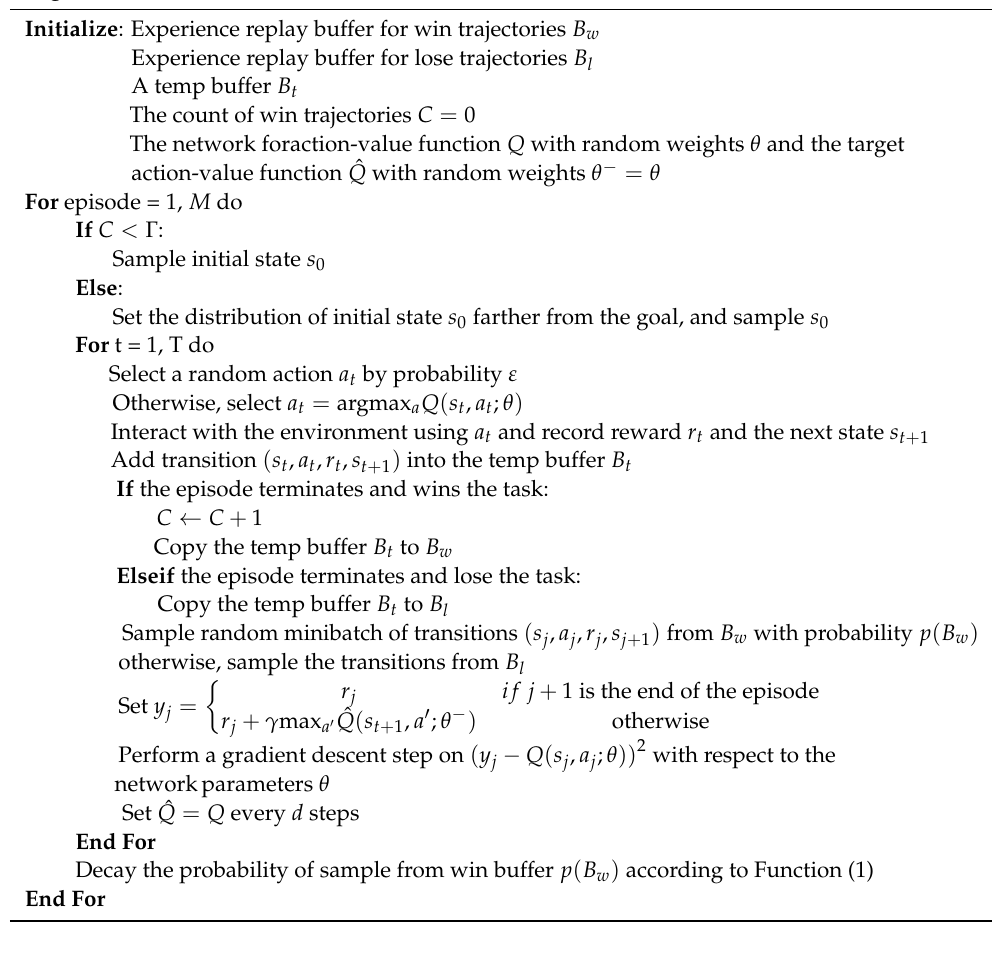
Algorithm 1. Data-efficient